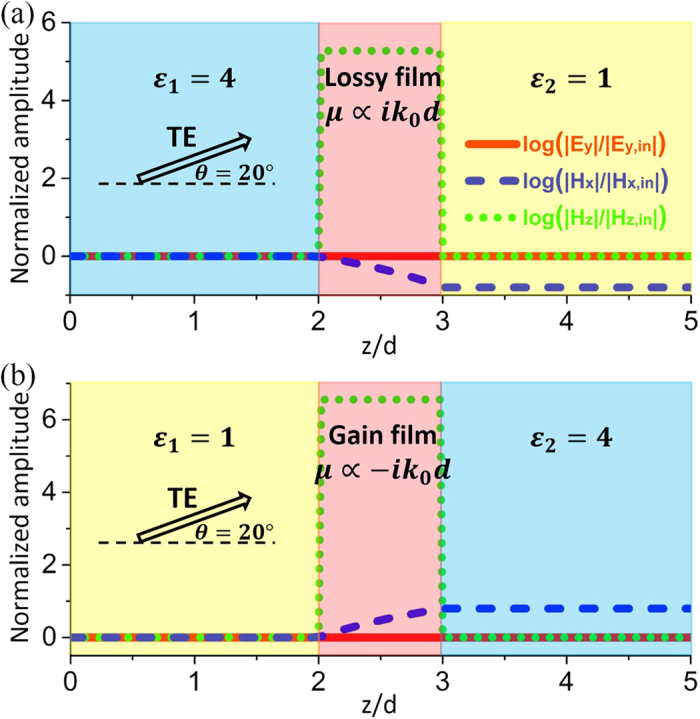
ARCs composed of ZIM for oblique incidence.Simulated normalized amplitudes of electric and magnetic fields inside the ultrathin ARC composed of ZIM with (a) ε = 1, μ = 0.0051i ∝ ik0d and (b) ε = 1, μ = −0.0014i ∝ −ik0d under oblique incidence with θ = 20°. The thickness of the ARC is d = λ0/500. The relative permittivities of the dielectric media 1 and 2 are, respectively, (a) ε1 = 4 and ε2 = 1, (b) ε1 = 1 and ε2 = 4.